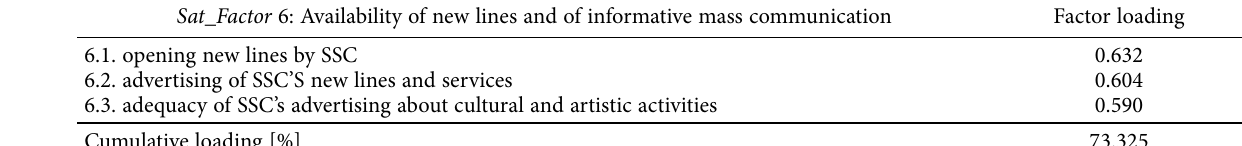
Table 9. Satisfaction Factor 6 factor